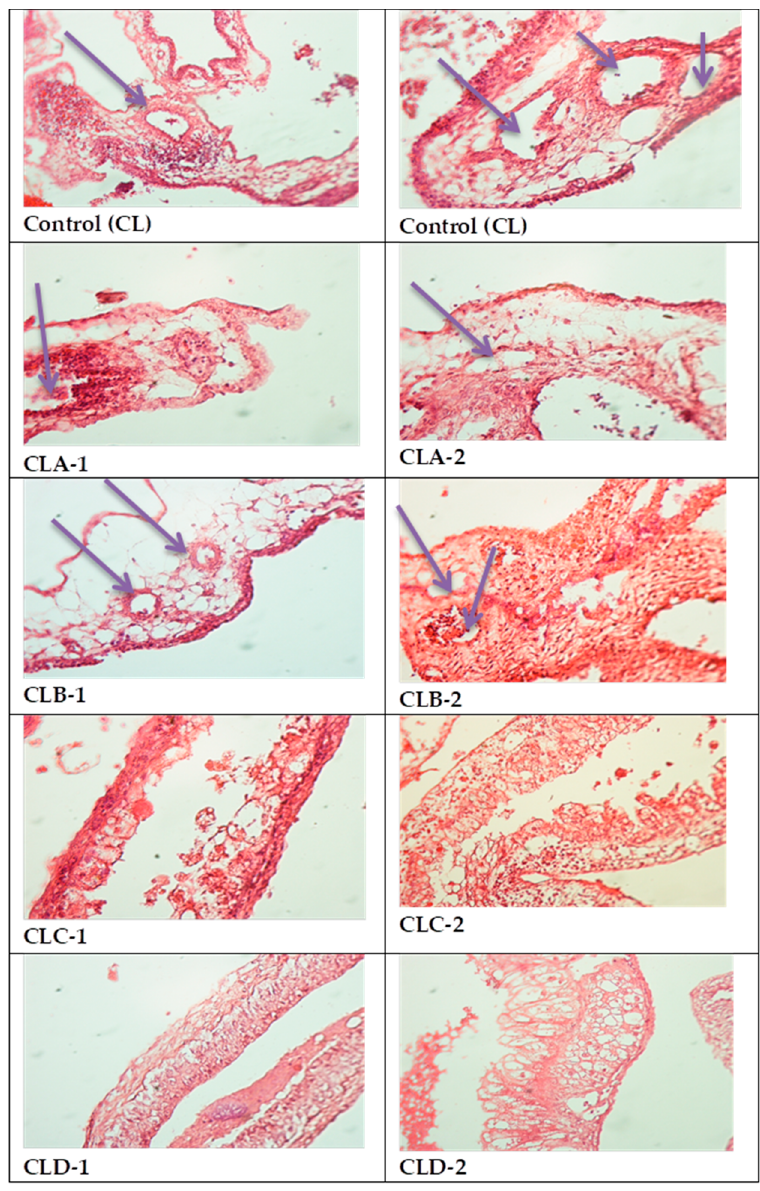
Figure 7. CAM Angiogenesis Model (microscopic images)- Control (CL): Abundant vascularization dispersed in mesenchyme; CLA-1, CLA-2: Vascular network present, but large mesenchymal areas do not present vasculature; CLB-1, CLB-2: Very small variability of vascular supply; CLC-1.CLC-2 : Significant decrease of blood vessels presence; CLD-1, CLD-2: Significant decrease of vascular support.